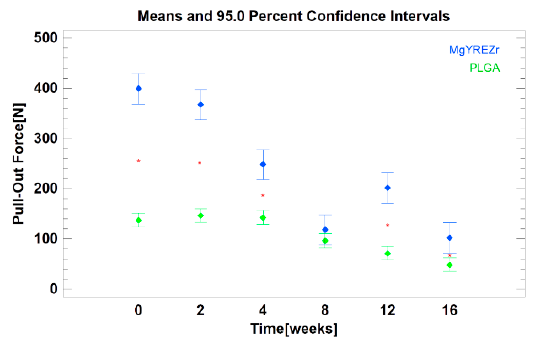
Figure 2. Comparison of axial pull-out force of magnesium alloy screw (blue) versus control: poly(lactic-co-glycolic acid) screw (green). The confidence intervals (brackets), mean values (points), and the statistical difference between two groups for each time point (asterisks) were determined.